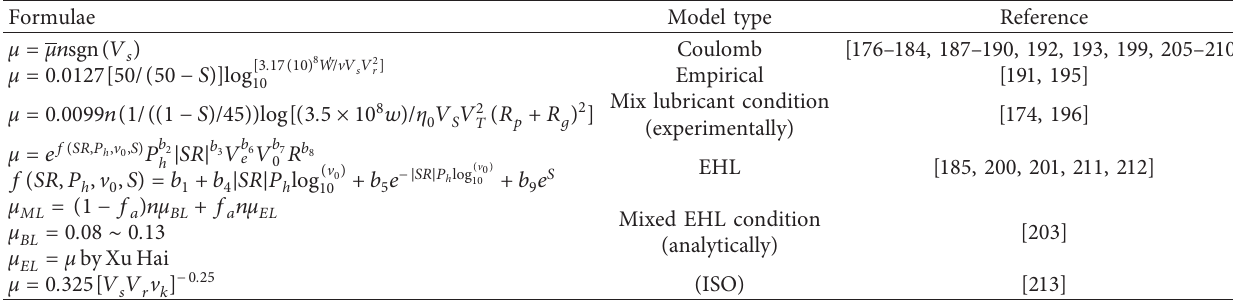
Table 4: Formula of the friction force